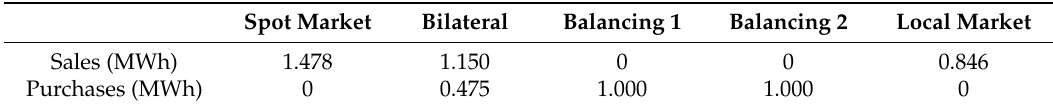
Table 1. Scheduling of sales and purchases in the different